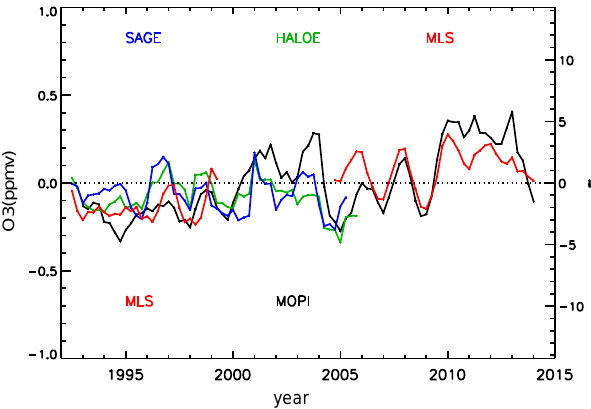
Figure 7. Annual average ozone anomalies at 10hPa (30km for SAGE II) shown 4-times annually (with annual averages for each instrument taken from January to December, April to March, July to June, and October to September). Results are shown for SAGE II (blue), HALOE (green), UARS and Aura MLS (both red), and MOPI1 (black). Satellite measurements (latitudinal averages from 40 to 50 ◦ S) have been offset so that the average ozone matches that of MOPI1 during the period of